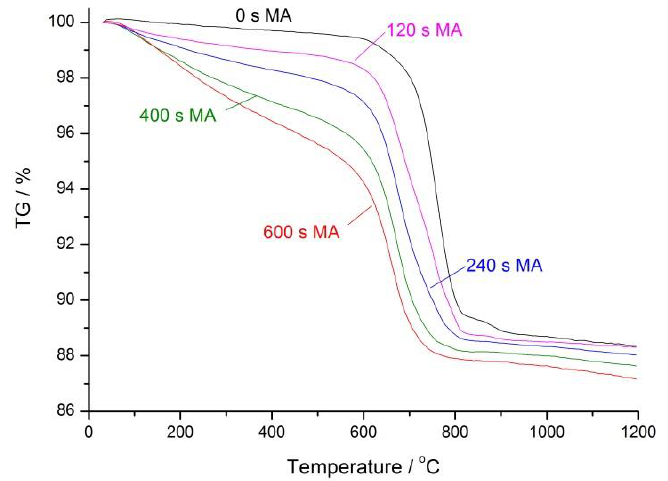
Figure 5. Thermogravity curves for initial and mechanically-activated antigorite (moderate mechanical activation in air).